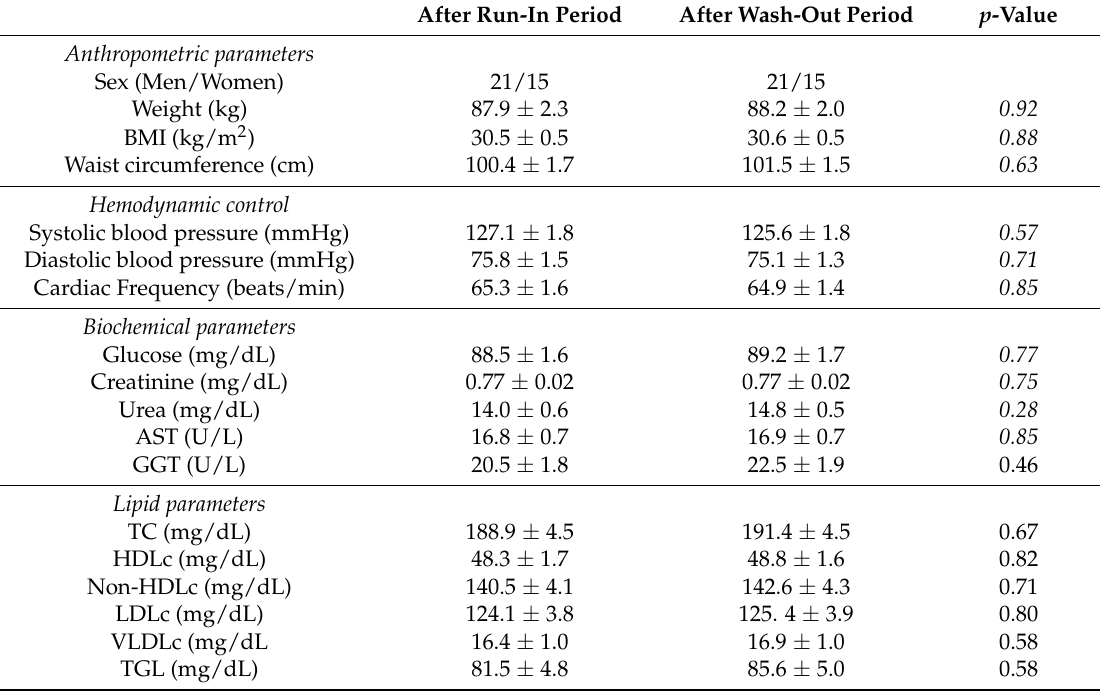
Table 1. Subject characteristics at baseline for phase 1 and for phase 2, at the time of starting each intervention period ( N = 36). After Run-In Period After Wash-Out Period p -Value Anthropometric